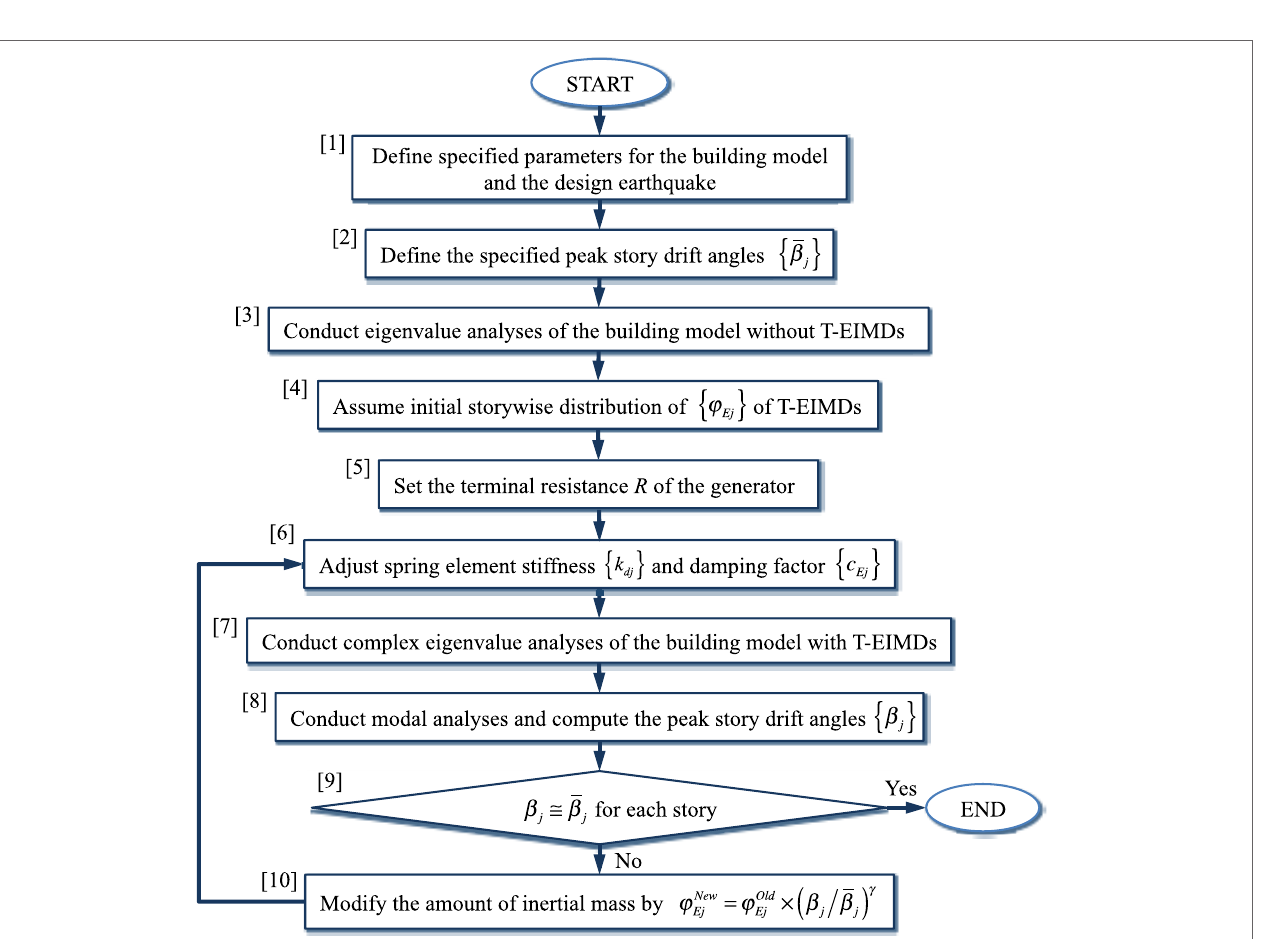
FIGURE 6 | Flow for design of tuned electromagnetic inertial mass dampers (T-EIMDs) for specified story drift angles .